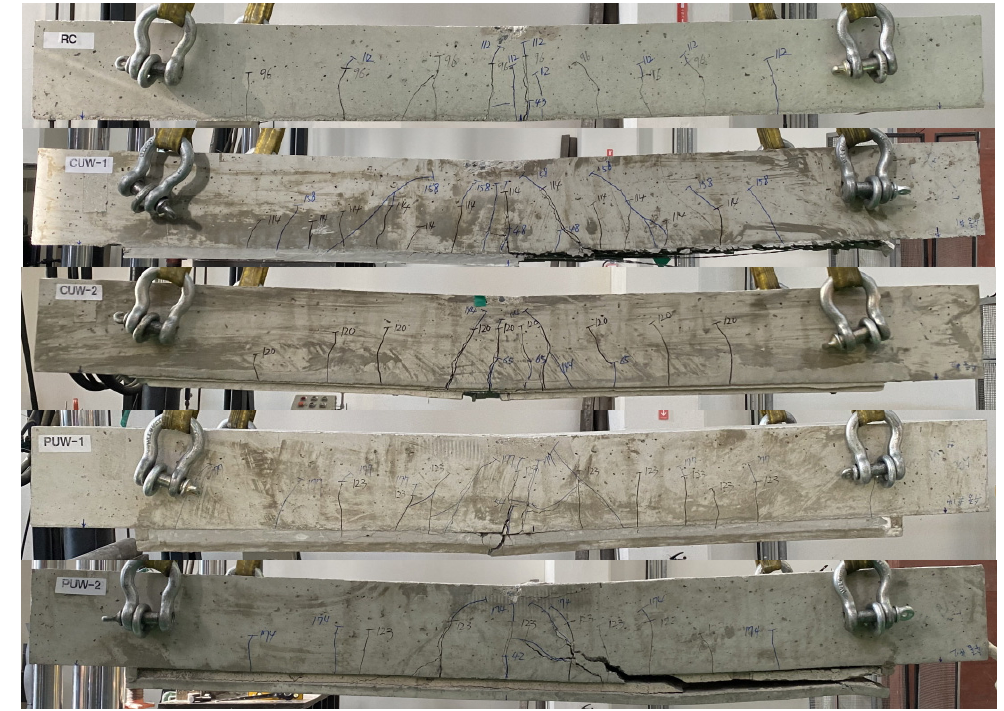
Figure 15. Crack patterns and failure modes of specimens (side view).